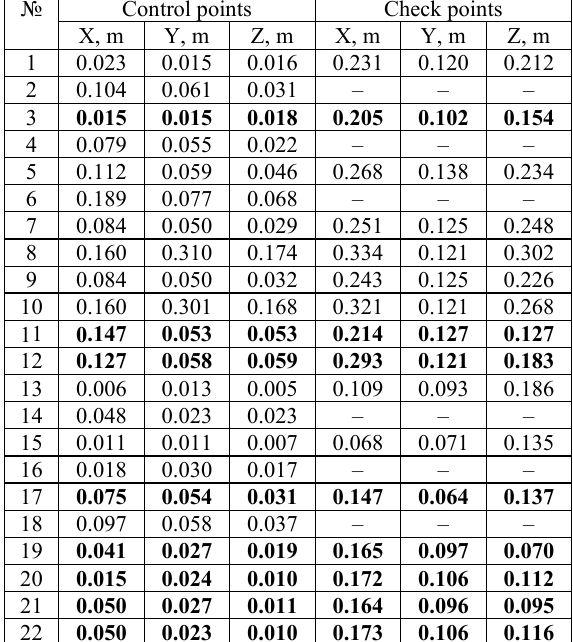
Table 2. Mean errors of generated photogrammetric models